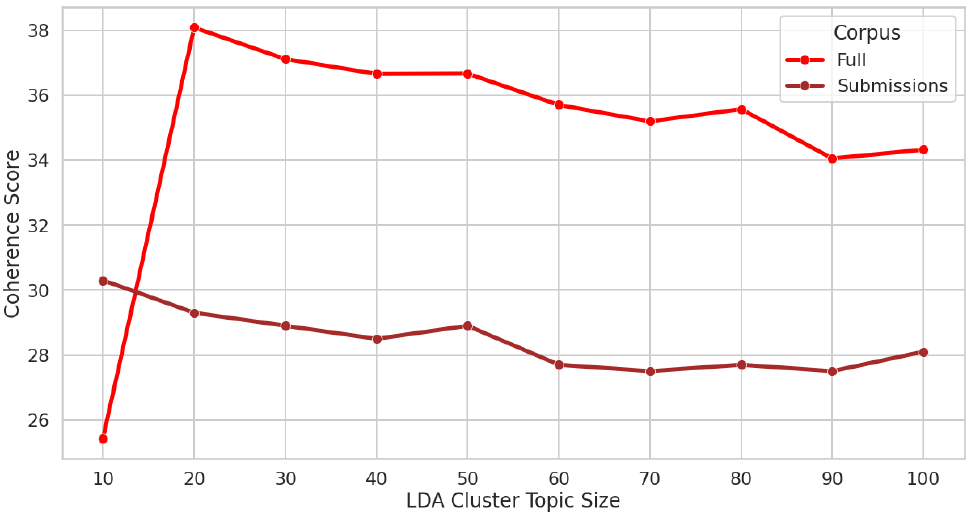
Figure 2. Coherence plots for determining LDA topic size hyperparameter in the Full Reddit dataset (Full) and the Submissions-only dataset (Submissions).